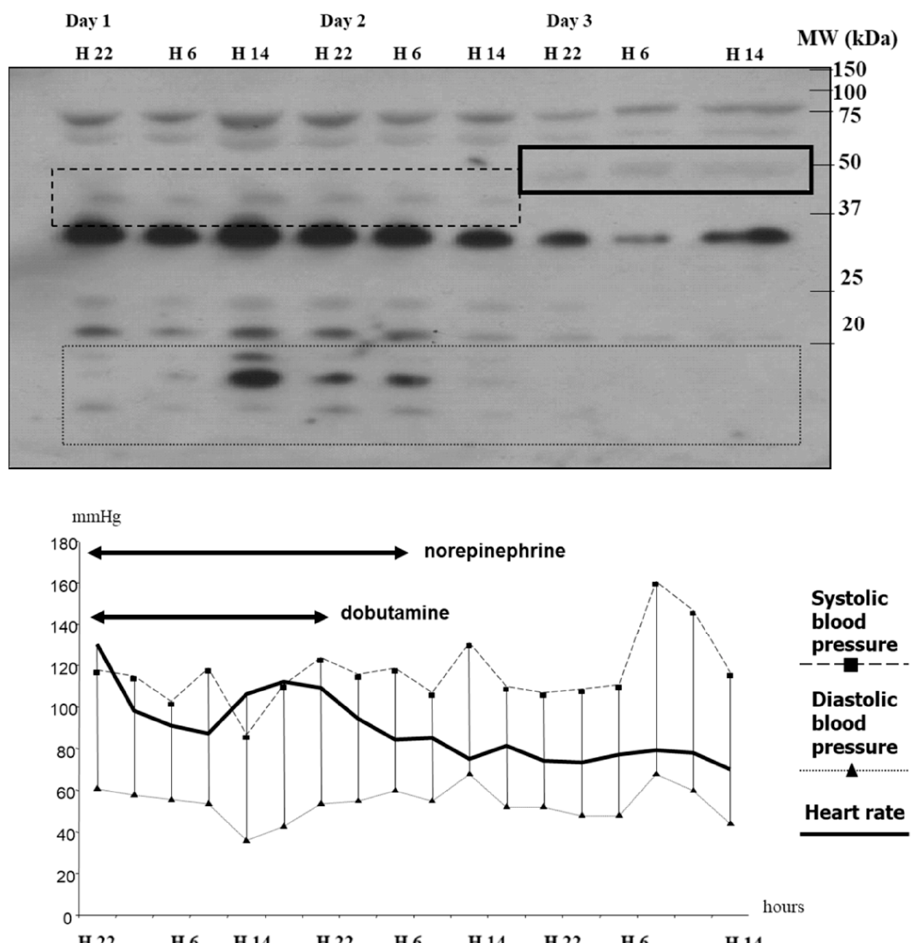
Figure 3. Typical Western blotting analyses of plasma samples to evaluate the time-dependent changes in extracellular processed VS-I ( top panel), and simultaneous hemodynamic profile ( bottom panel) during a human septic shock. Time (Day X) runs over 3 days from admission (Day 1, hour 10:00 pm (H22)) to the end of the third day (Day 3, 02.00 pm (H14) and is represented on the X-axis (top and bottom lines). Plasma samples harvested by 8 h, from admission until Day 3, were immediately centrifugated (4000 rounds/min at 4 °C), and SDS-PAGE electrophoresis followed by electrophoretic blotting with immunological detection of VS-I was performed in standard conditions. The anti-VS-I antibodies were a generous gift of Pr A. Corti, Milan, Italy. Periods of norepinephrine and dobutamine infusion are represented as bold arrows from admission until weaning. Please note that the processing of chromogranin A is notably changing around Day 2 at 2:00 (H14) when the patient’s circulatory status no longer requires the two vasopressors. The global immunoblots are decreasing in intensity, and both small and large molecule multimerization is decaying (top panel). This phenomenon is contemporary to the decrease in doses of vasopressors (norepinephrine and dobutamine) and corresponds to circulatory failure recovery. Altogether, these data explain (i) why dosages of any of these proteins must be performed at a similar time window of the disease if a proper interpretation of their role is to be considered; (ii) that a pharmacological intervention must be scheduled at a moment when it can be efficient. Thus, our data on 4% albumin-impact on multimerization show that such an intervention must start as early as possible after admission, and it has no sense after the 5th day of disease onset [16]. Please remember that the apparent molecular weight (MW) of full-length CGA is around 70–75 kDa, and that of VS-I is approximately 18 kDa, which explains the immunoblotting of multimers on the top panel. Boxes (solid line, dashed line . . . ) focus on processed molecules of interest, tagged with VS-I-antibodies: a careful identification must specify whether some multimers are not just large monomeric, full-length CGA molecules containing the VS-I